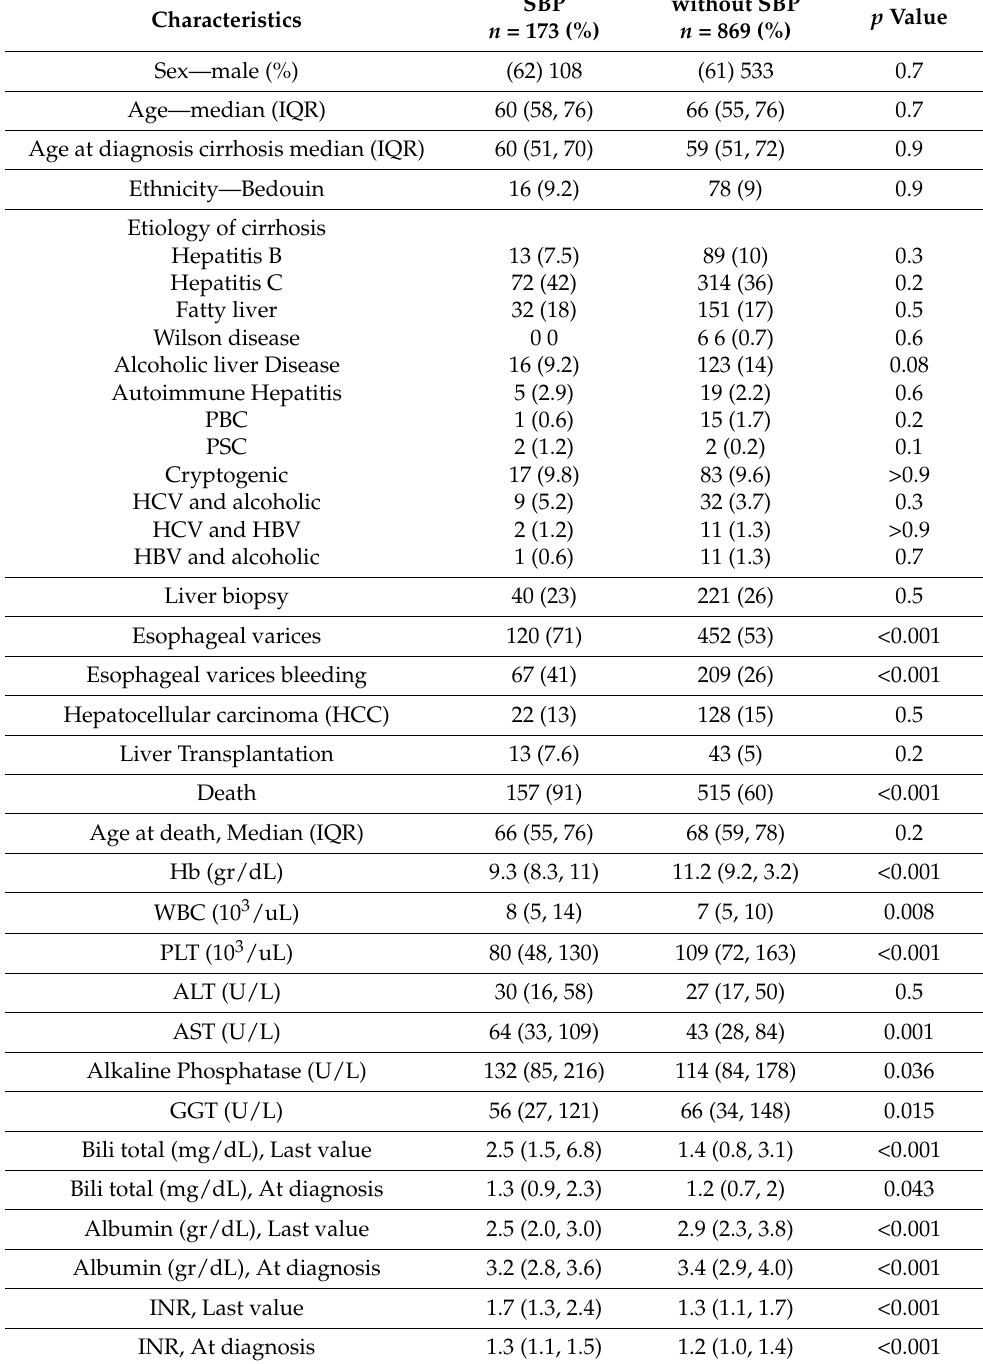
Table 1. Demographic and clinical characteristics of the included